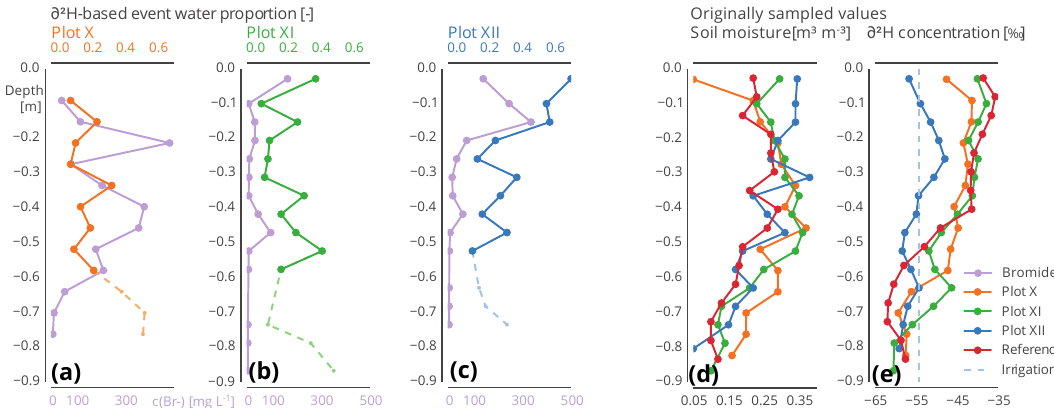
Figure D1. Plot-scale irrigation experiments. Proportion of event water derived from deviations in concentrations of deuterium and bromide in the soil water of sampled cores to the reference (a–c) . Absolute measured soil water content (d) . Deuterium concentration in samples and signature of irrigation water (e) . Note that the δ 2 H concentration profiles and the signature of the irrigation water show low deviation and even coincide at 0.5m depth. Thus the interpretation needs precaution, especially below that level (dashed lines, a–c ).